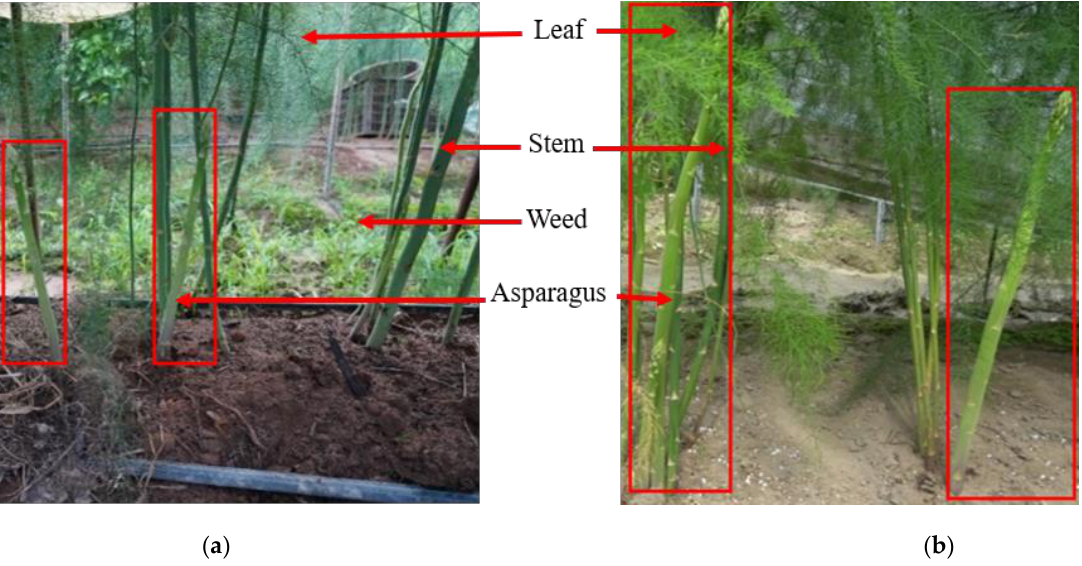
Figure 2. Photos of asparagus under different lighting conditions. ( a ) Image acquired on a cloudy day; ( b ) image acquired on a sunny day.